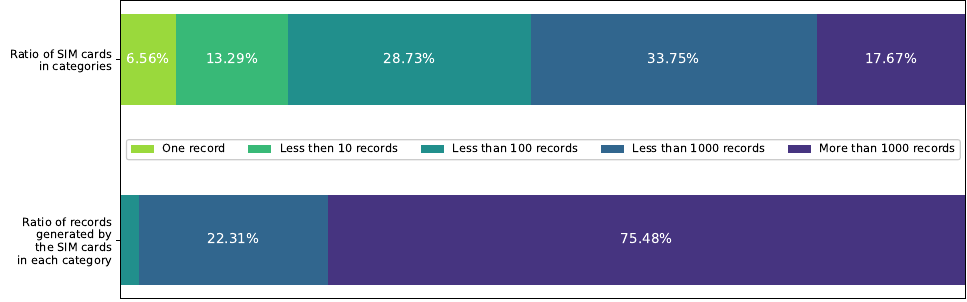
Figure 1. SIM cards in the 2017-04 data set categorized by the number of activity records. The cate- gories are: only 1 record, 1 to 10 records, 10 to 100 records, 100 to 1000 records and greater than 1000 records. The SIM cards in the last category (17.7% of the SIM cards) provide the majority (75.48%) of the